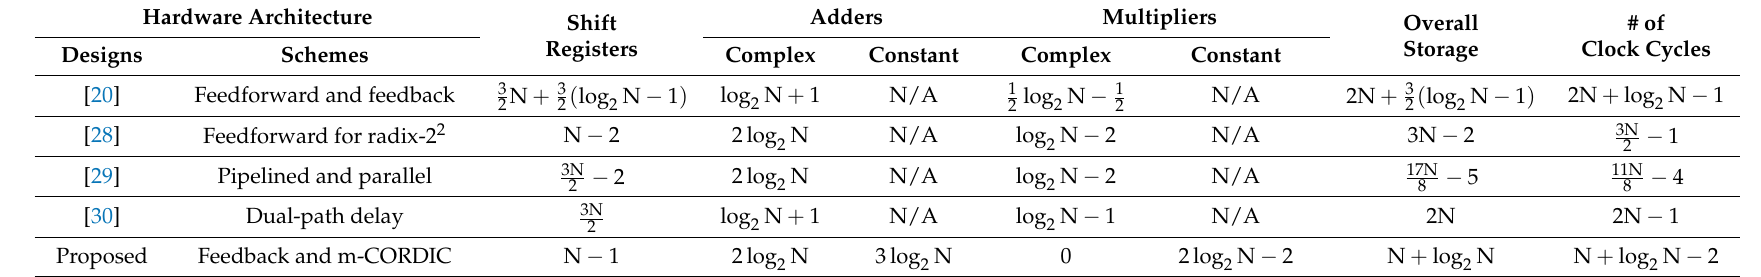
Table 5. Comparison of the hardware resources needed by the various architectures for an N-point FFT implementation.